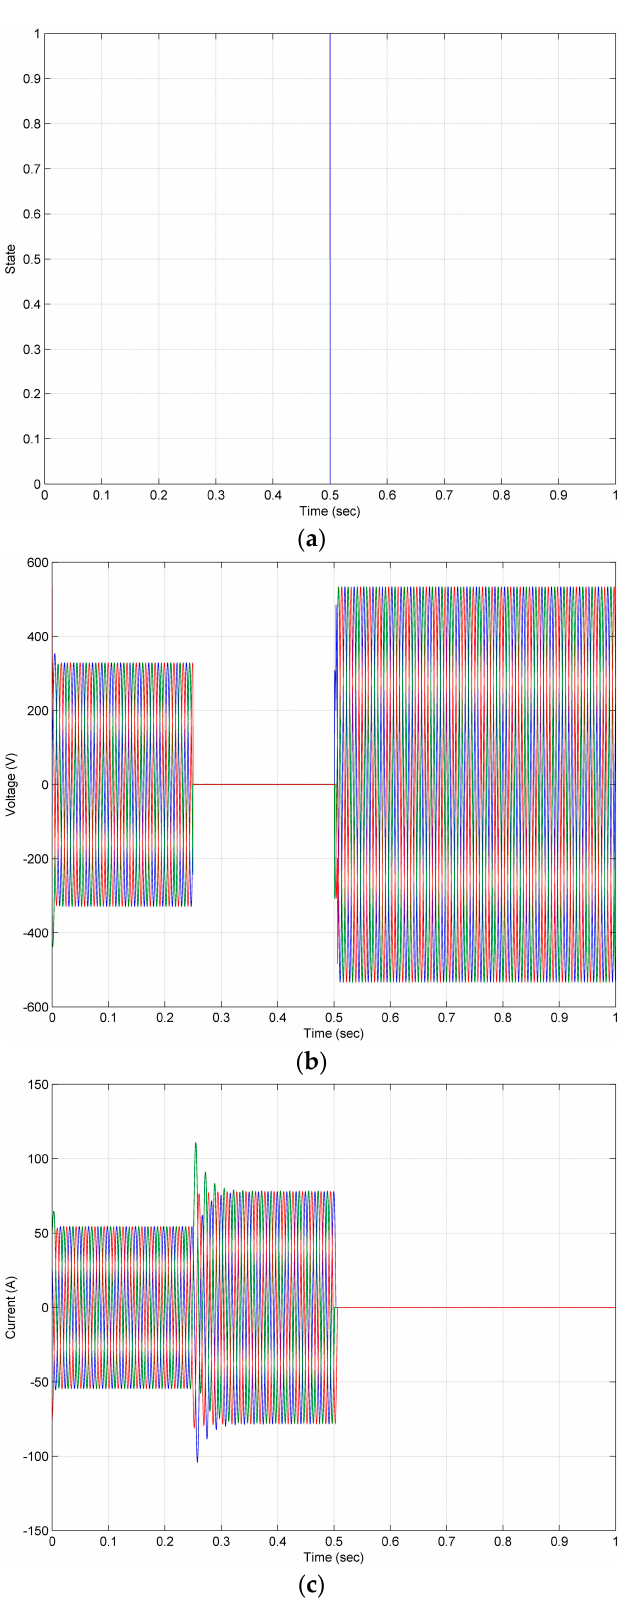
Figure 15. ( a ) CB1 CLOSE/TRIP state; ( b ) Feeder voltage waveforms of CB1 under islanded mode and fault occurrence at Bus 2; ( c ) Feeder current waveforms of CB1 under islanded mode and fault occurrence at Bus 2.